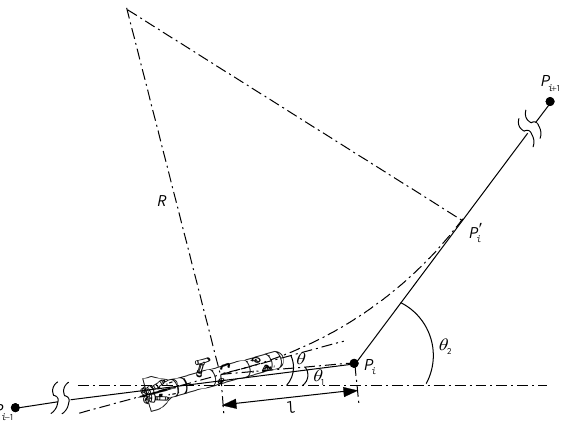
Figure 24. Arc transiting strategy at the corner.